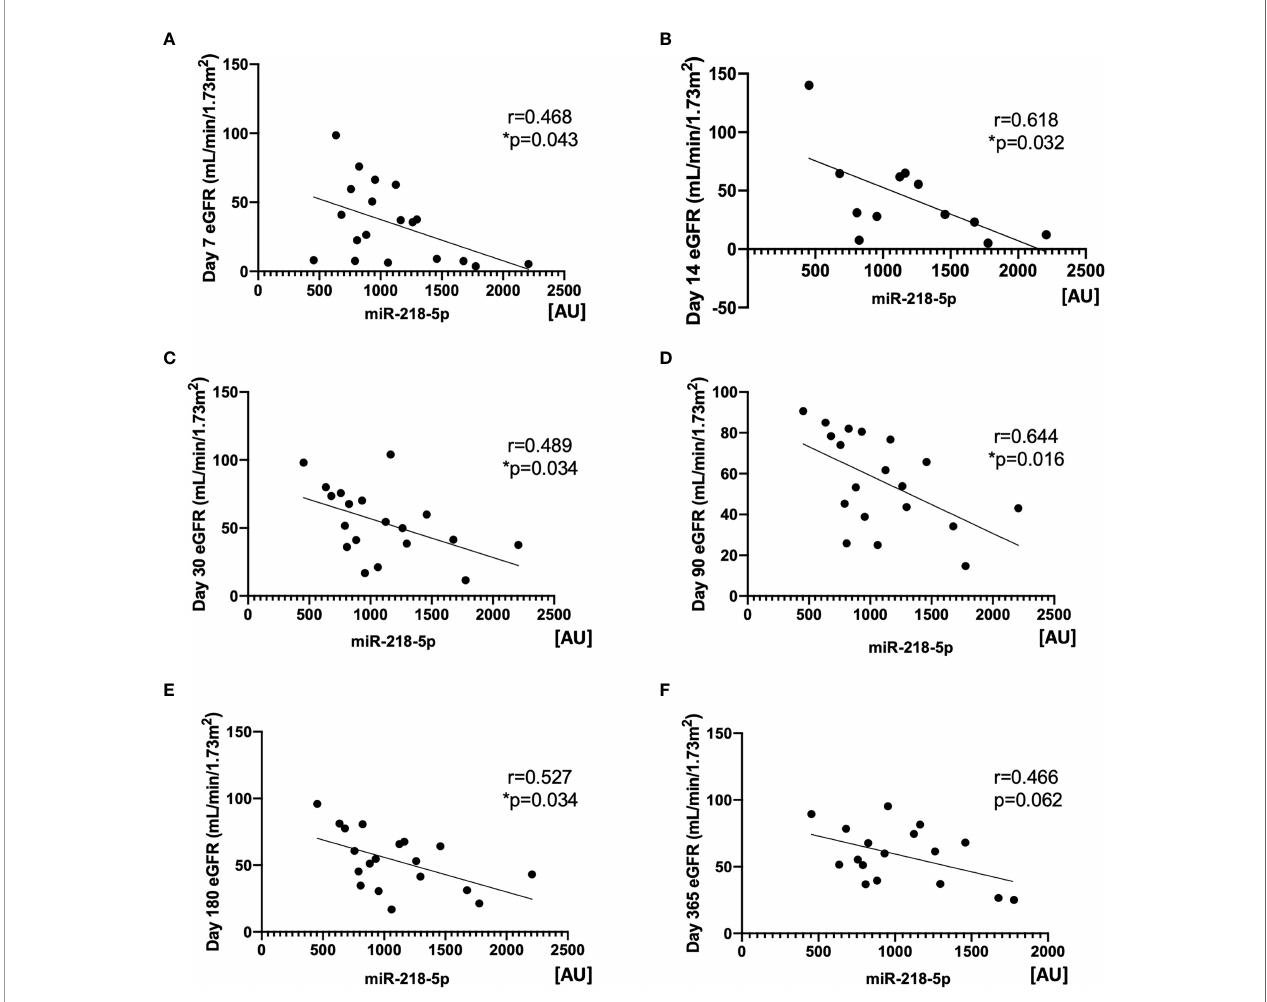
FIGURE 6 | Expression of miR-218-5p in KP-EV negatively correlates with kidney transplant recipient eGFR. (A-F) Correlation of KP-EV miR-218-5p expression levels as measured by miRNA sequencing with respective recipient eGFR at (A) day 7 (B) day 14 (C) day 30 (D) day 90 (E) day 180 and (F) day 360 following transplantation. *represents p-values ≤